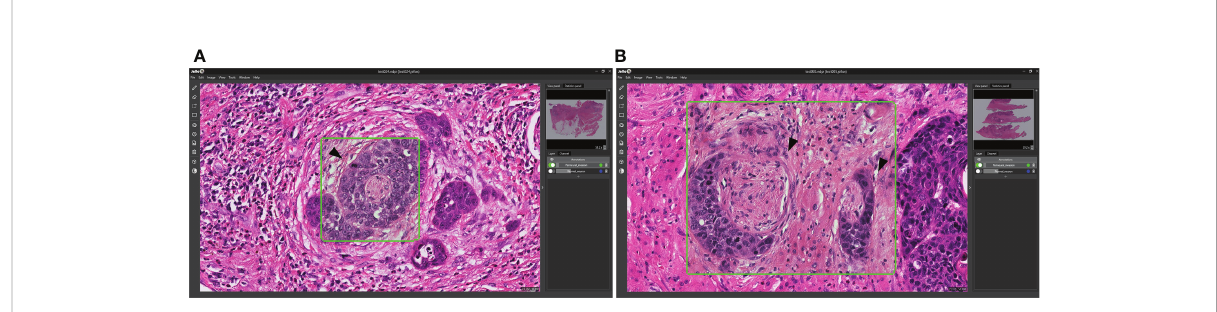
FIGURE 7 Validation of the Domain-KEY algorithm for identifying PNI in oropharyngeal and hypopharyngeal malignancies. (A) Identi fi cation of PNI in oropharyngeal carcinoma (green box). The arrowhead indicates the tumor surrounding the entire nerve (B) . Identi fi cation of PNI in hypopharyngeal carcinoma (green boxes). The arrowhead indicates the tumor that focally touched the perineurium.